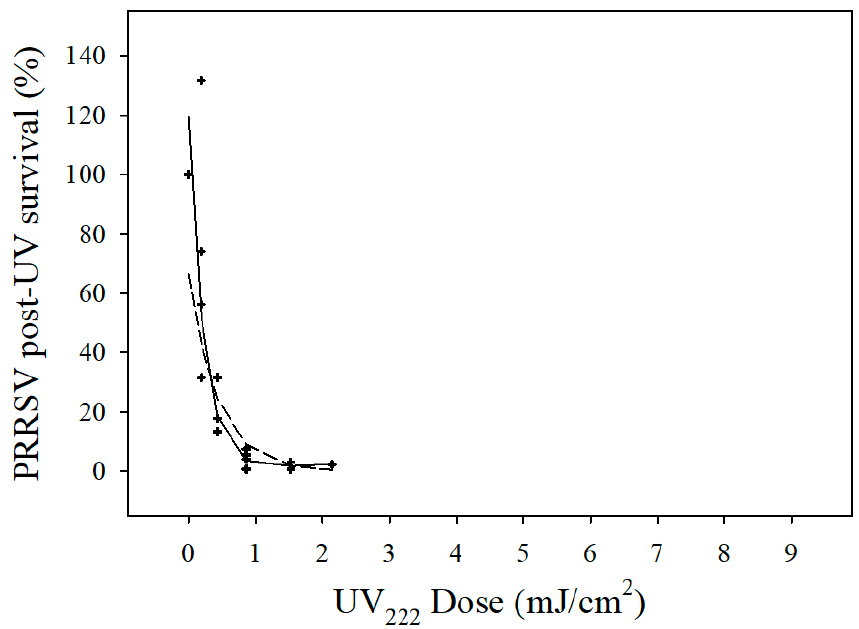
Figure 3. UV-C (222 nm) treatment inactivation of aerosolized PRRSV. PRRSV post-UV survival (%) = N t /N 0 . A log 10 normalized PRRSV post-UV survival is shown in Figure A2. One-stage and two-stage inactivation models are marked with dashed and solid lines, respectively.